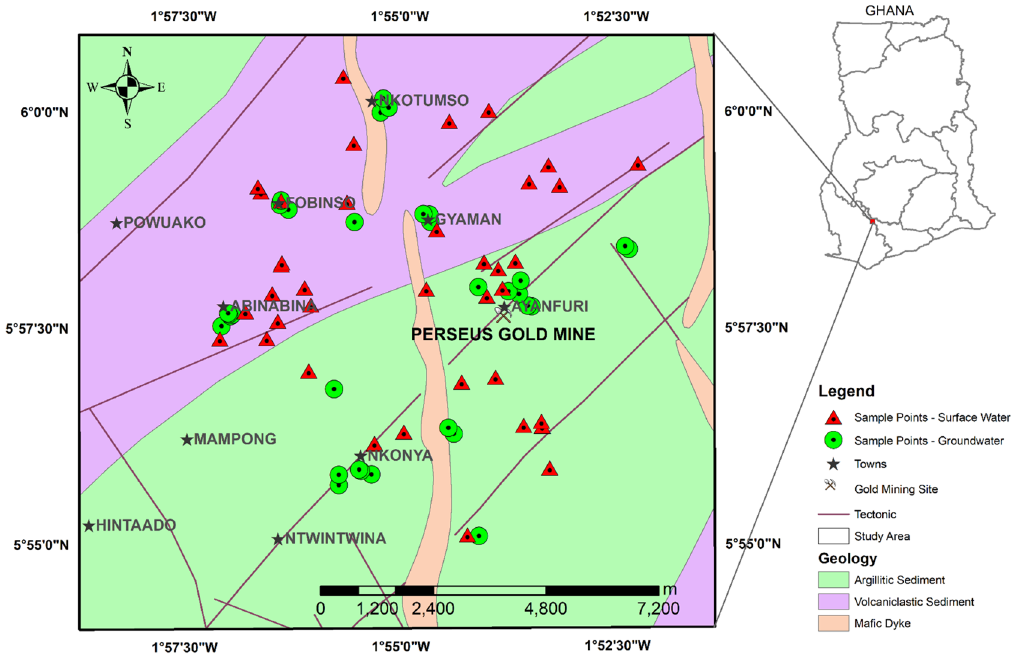
Figure 1. Location and geological map of the study area.